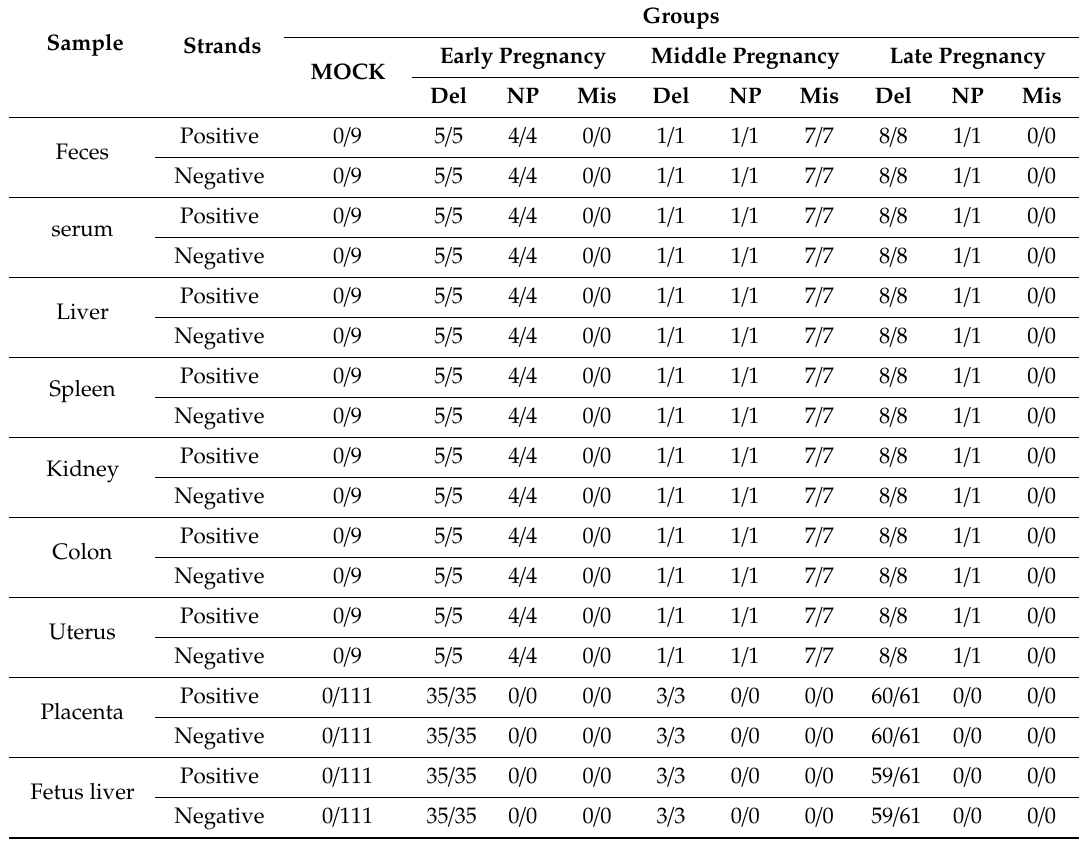
Table 1. HEV RNA detection in HEV-infected pregnant